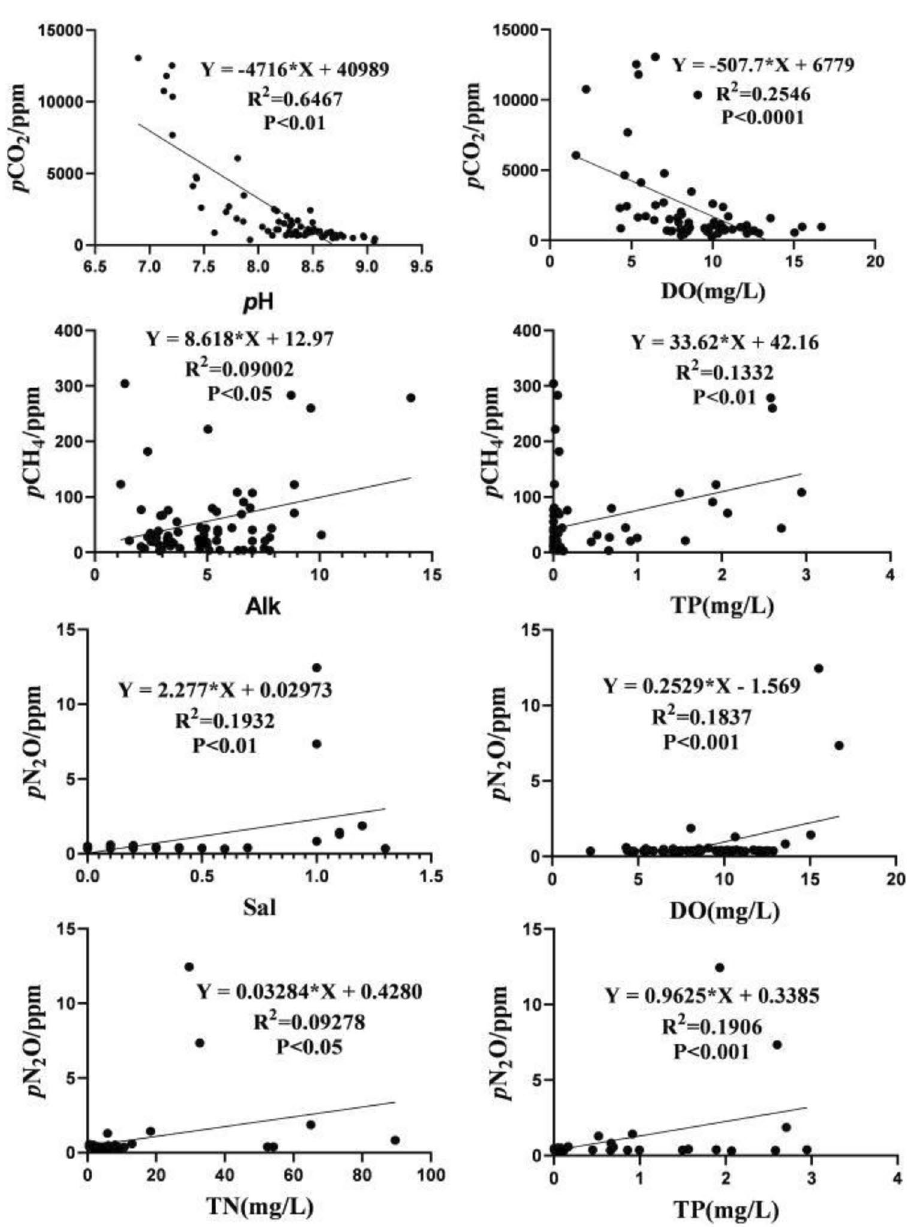
Figure 10. Relationship between p GHG and water quality